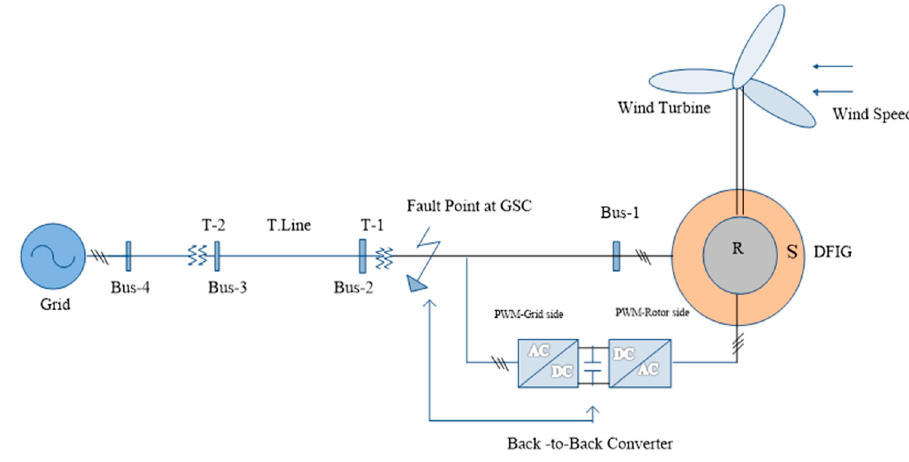
Figure 2. The block diagram of the doubly-fed induction generator (DFIG)-based wind power system.